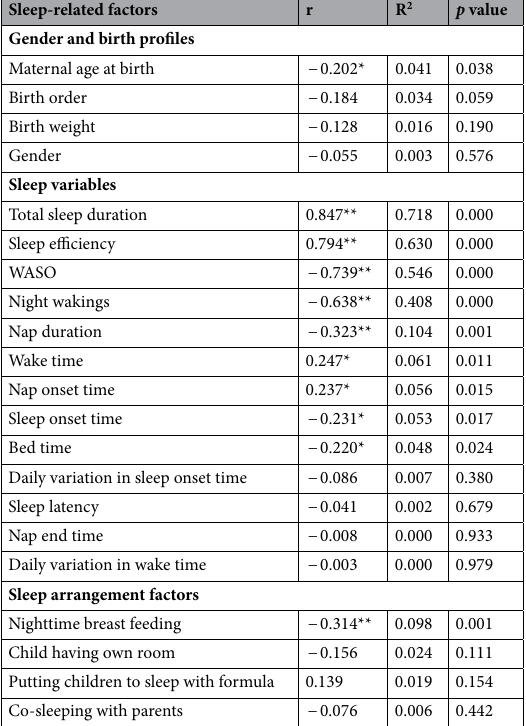
Variables Model 1,OR (C.I.) Model 2,OR (C.I.) Model 3, OR(C.I.)